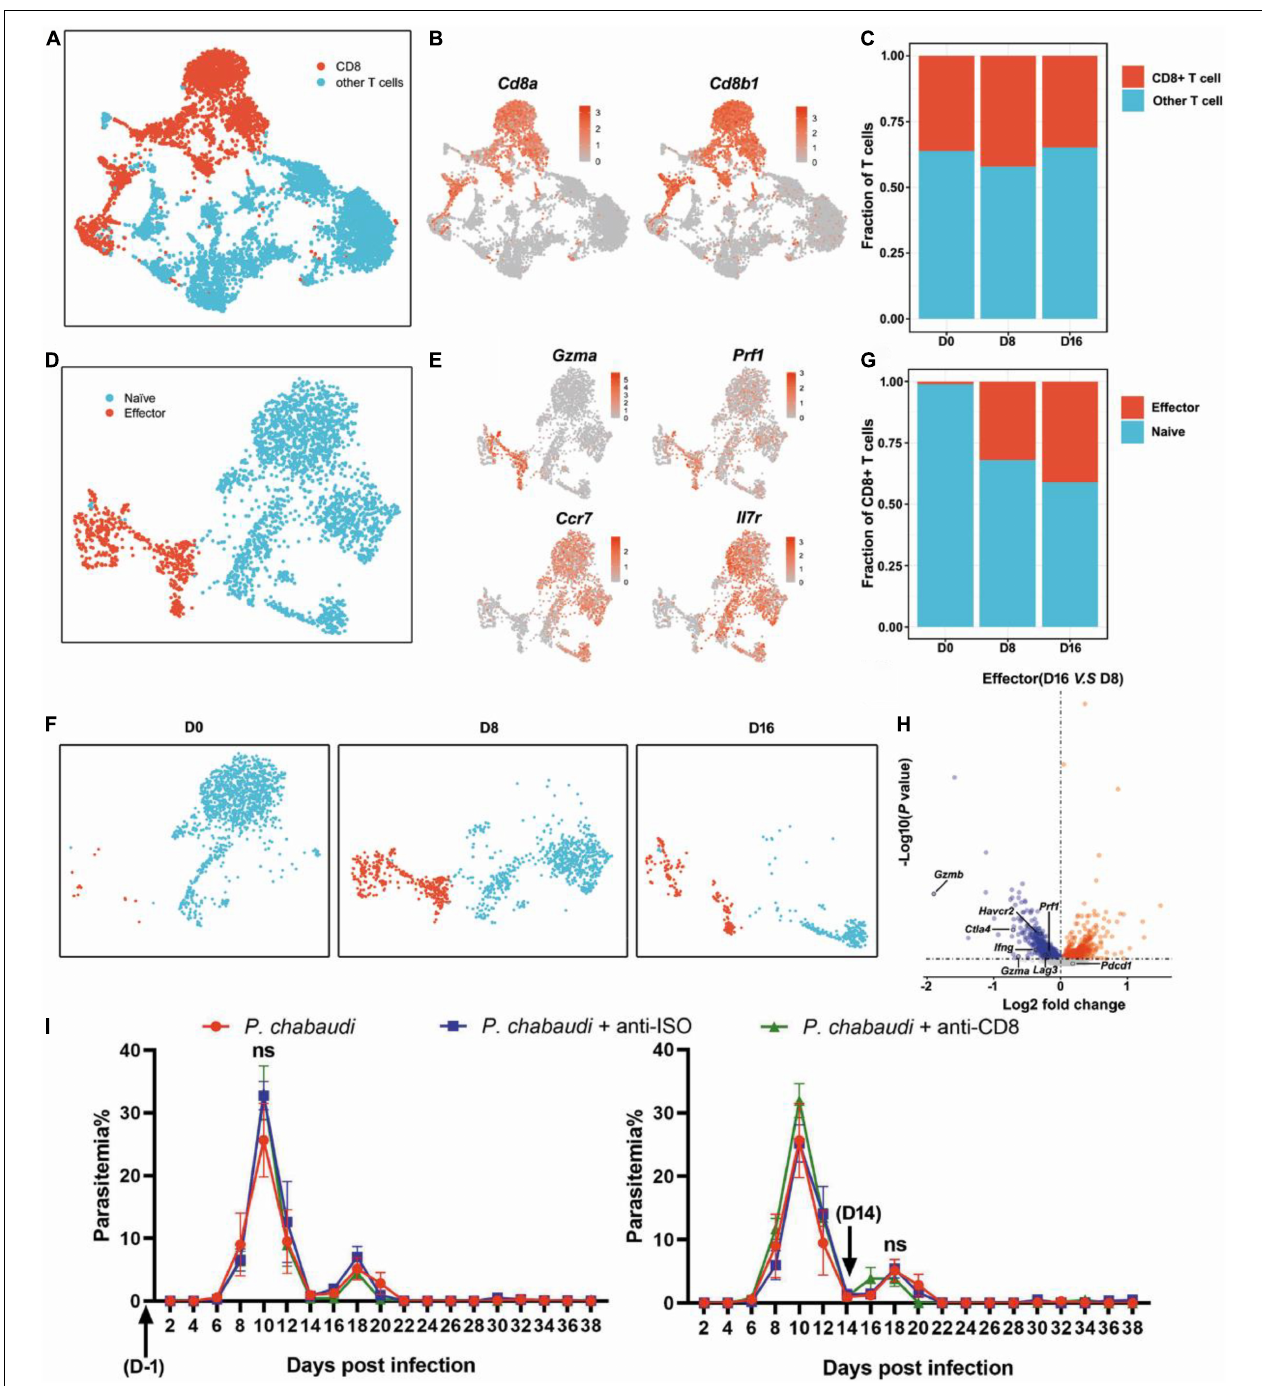
FIGURE 4 | CD8 + T cells are dispensable for control of both the acute and recurrent stage of P. chabaudi infection. (A) UMAP projection plot of T cell populations merged from the three time points. (B) Feature plots depicting single-cell expression of canonical immune cell markers of CD8 + T cells. (C) Cell abundance frequency of CD8 + T cell relative to the total number of T cells at each time point. (D) UMAP visualization of the CD8 + T cells merged from all samples. (E) Expression of markers driving heterogeneity of CD8 + T cells subtypes, including the naïve and effector CD8 + T cells. (F) UMAP plot from (D) split into the three stages of infection. (G) Abundance of each population relative to the total number of CD8 + T cells at each time point. (H) Volcano plots depict differential gene expression between clusters of cells, with a P -value of < 0.05. Blue represents downregulated genes and red represents upregulated genes. (I) WT mice ( n = 5) were injected with anti-CD8 or control IgG on days –1, 1, 3, 5, 7 or days 14, 16, 18, 20, 22 after the challenge. All experiments were performed in triplicates and the data are presented as means ± the SD. ns, not significant.